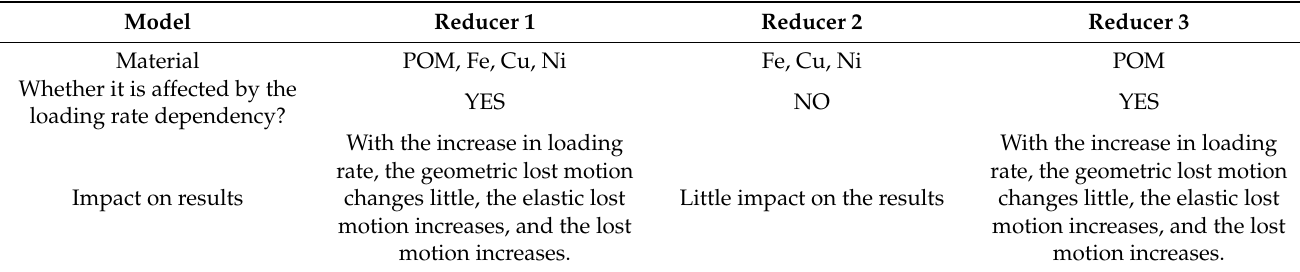
Table 13. Experiment